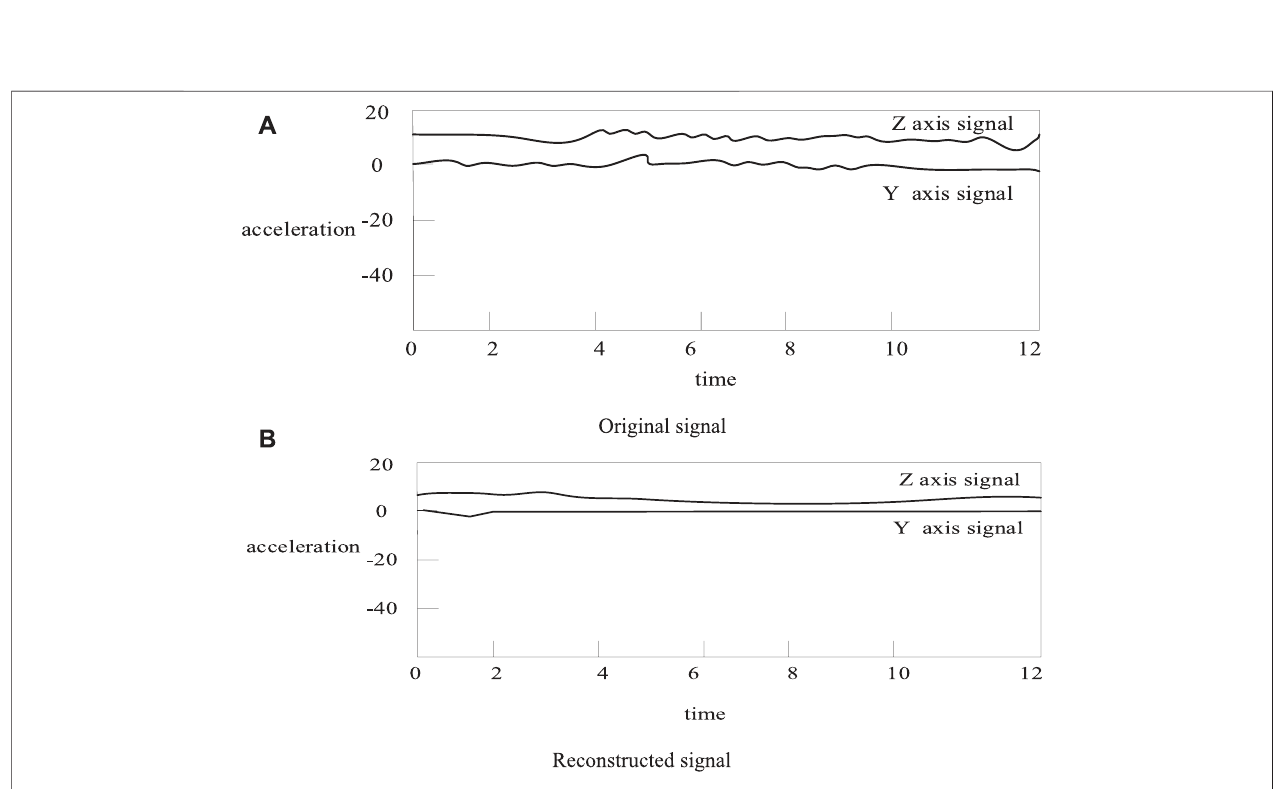
FIGURE 5 | Signal comparison before and after unscented Kalman fi ltering. (A) Original signal (B) Reconstructed signal.